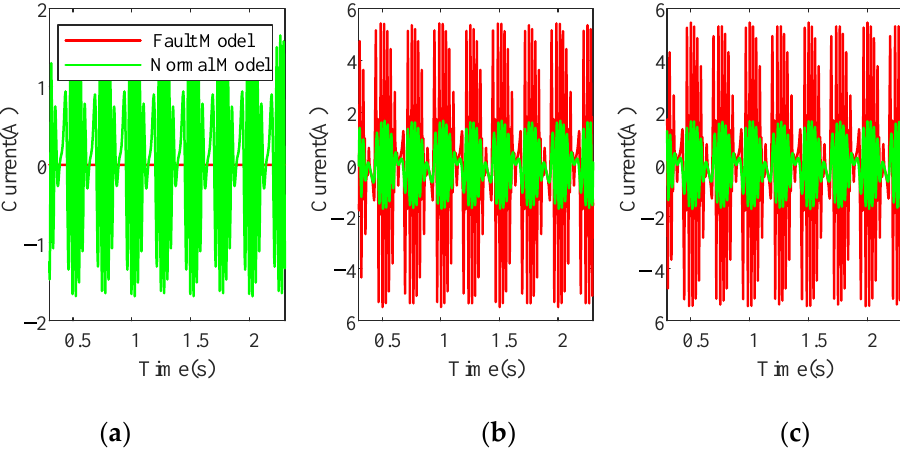
Figure 12. Fault data of A-phase both IGBT open circuits. ( a ) A-phase current; ( b ) B-phase current. ( c ) C-phase current.